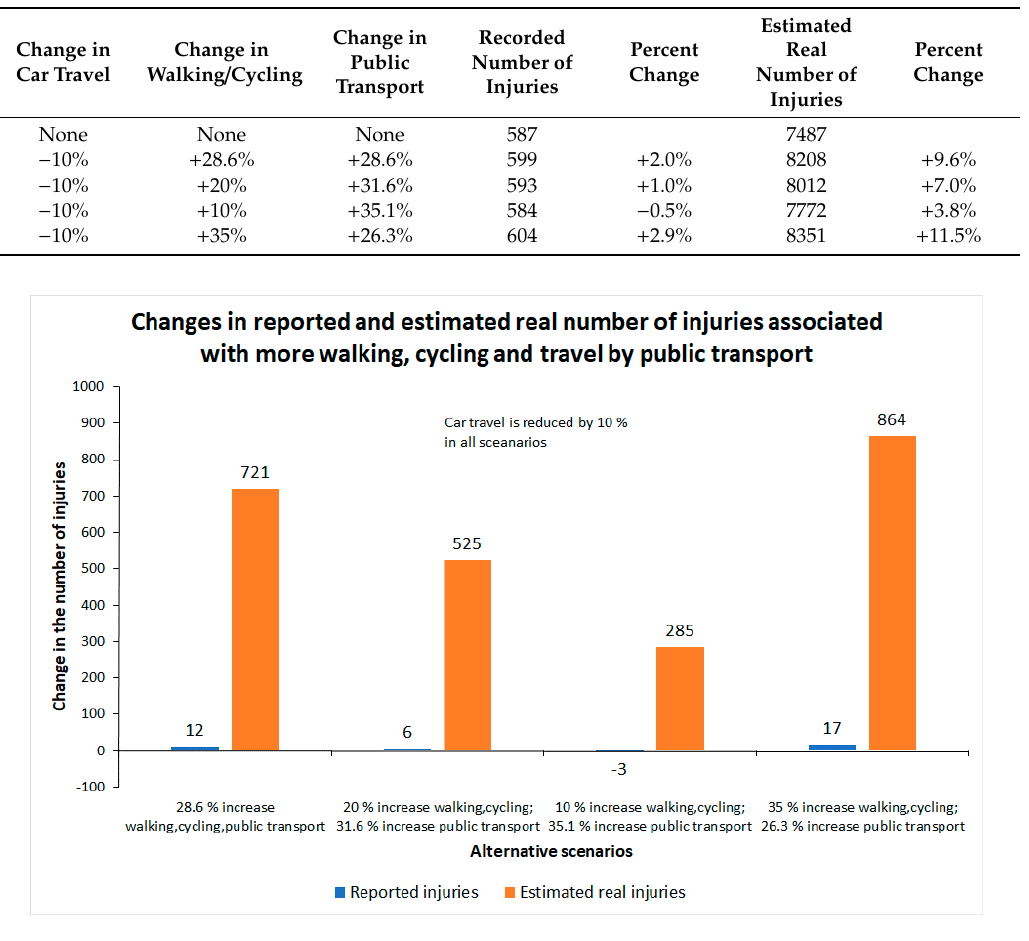
Figure 3. Impacts on traffic injury of four scenarios involving more walking, cycling and travel by public